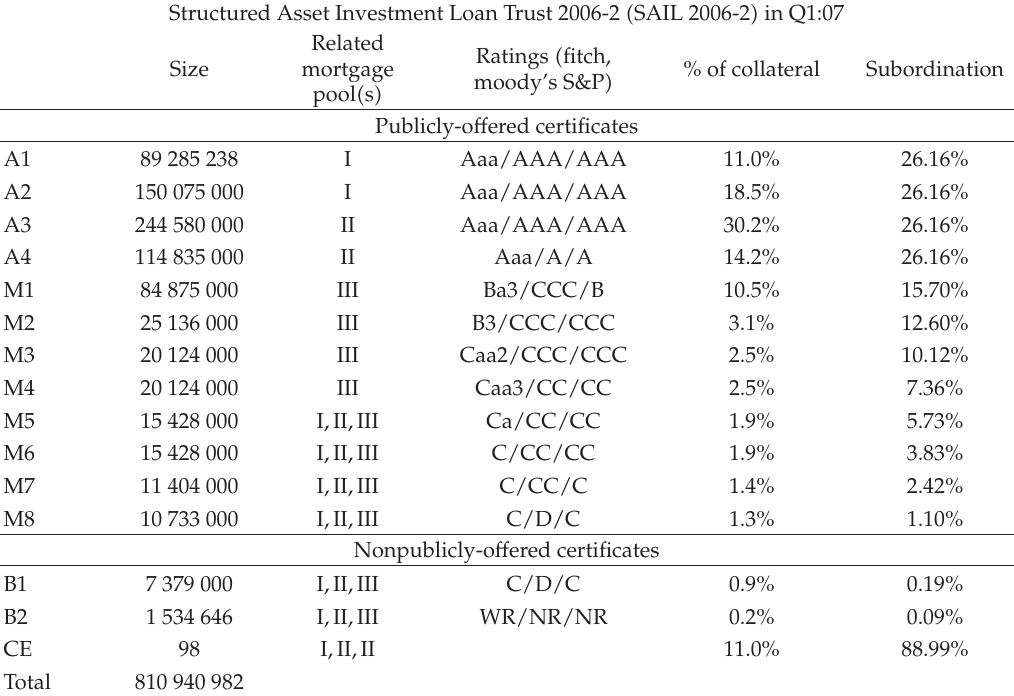
Table 11: Structured Asset Investment Loan Trust 2006-2 (cid:2) SAIL 2006-2 (cid:3) In Q1:07; source: (cid:6) 25 (cid:7) . Structured Asset Investment Loan Trust 2006-2 (cid:2) SAIL 2006-2 (cid:3) in